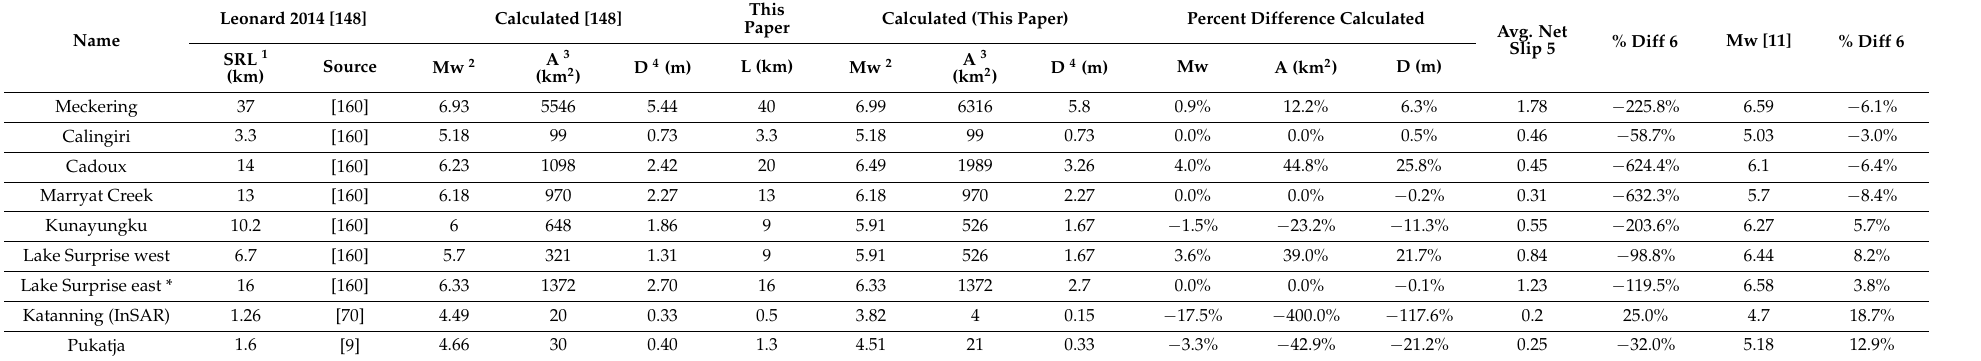
Table 10. Comparisons between calculated magnitude, area and displacement from previous length scaling relationship [148] using surface rupture length from [148] and length from this